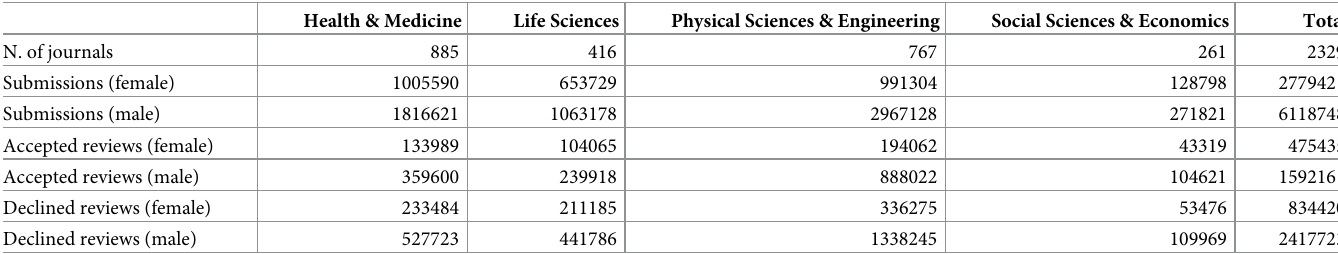
Table 1. Overview of the main variables considered in the analysis by area of